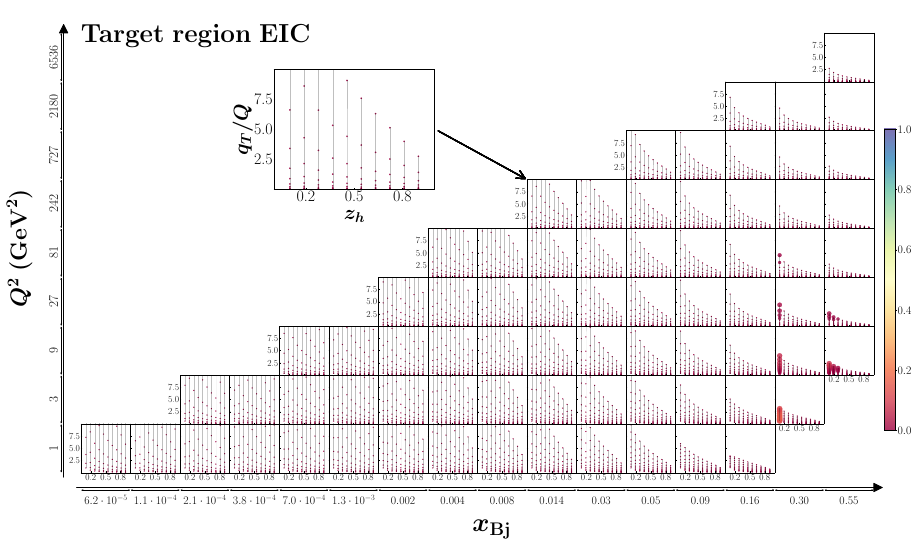
Figure 14 . Affinity for the target fragmentation region at EIC kinematics.